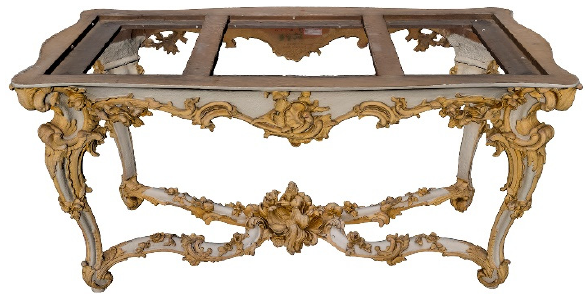
Figure 2. 3D model of the original rococo desk.